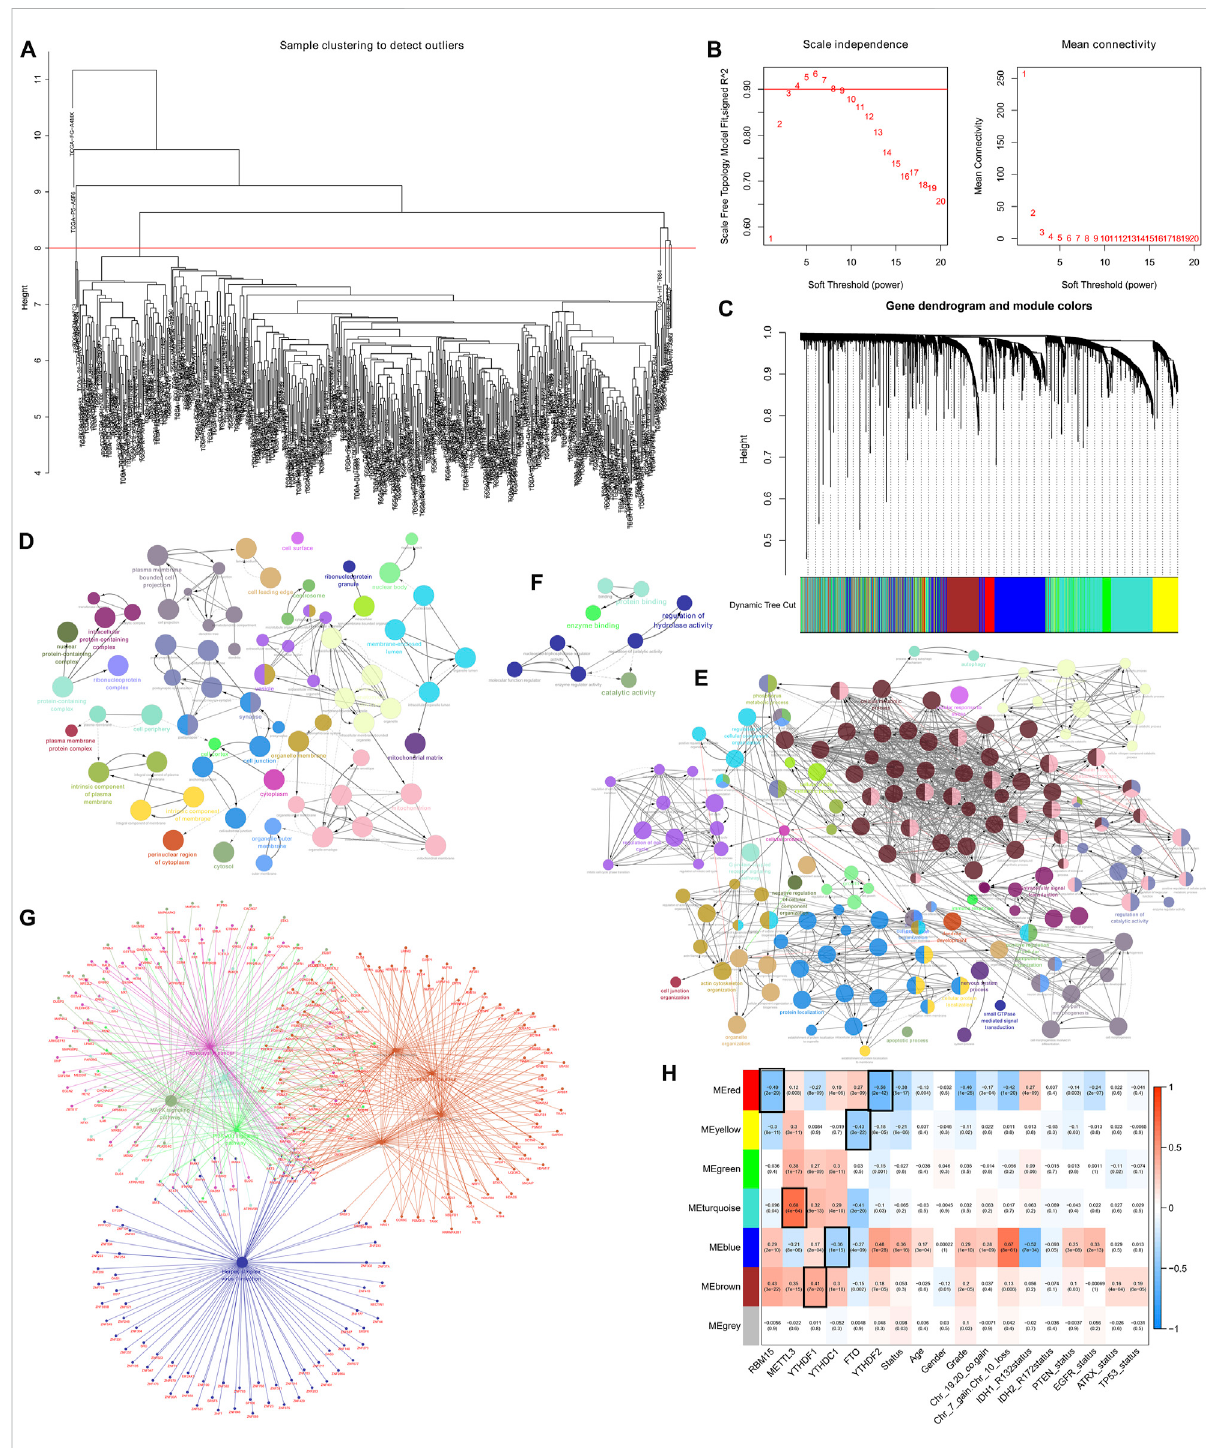
FIGURE 2 Determination of the AS events that are correlated with clinical characteristics and the m6A regulator expression (A) Sample dendrogram and traitindicator. (B) Assessmentofthesoft-thresholdpowerofWGCNAanalysis (C) TheASeventsinLGGsamplesareclusteredhierarchically.Thetree representsanLGGwithadistinctnameandexperimentidenti fi cation. (D – G) Genesassociatedwithm6A-relatedASeventsinLGGweresubjectedto analysis using GO terms and KEGG pathways. The GO terms (D – F) and KEGG pathways enrichment (G) analysis of the m6A-related prognostic AS genes in LGG (H) Association of the AS events with m6A methylation regulatory genes, age, gender, grade, Chr 7 gain/Chr 10 loss, as well as Chr 19/20 co-gain, mutations status of IDH1 ( R132 ), IDH2 ( R172 ), PTEN , EGFR , ATRX , and TP53